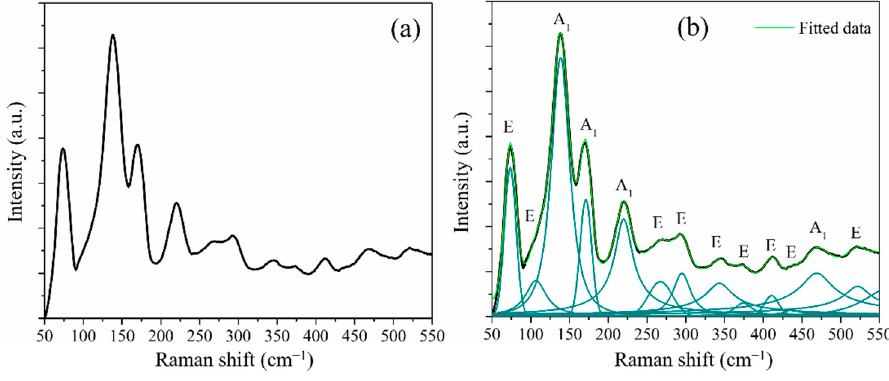
Figure 3. ( a ) Raman spectrum of BiFeO 3 system. ( b ) Deconvolution of the Raman